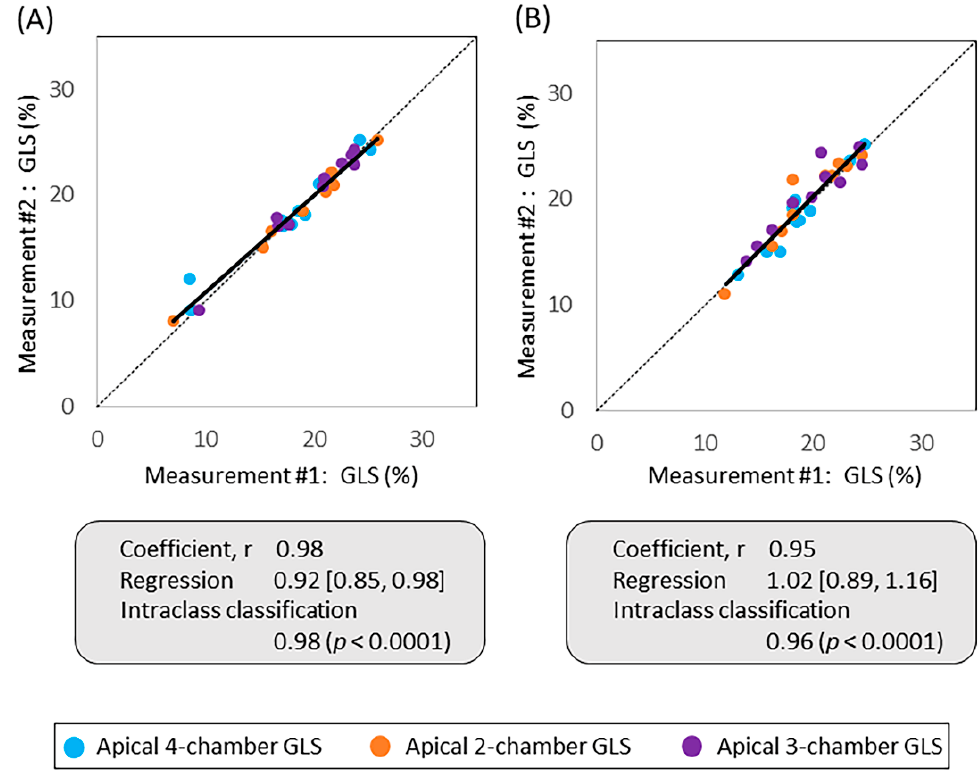
Figure 4. Intra-observer variability in apical 4-, 2-, and 3-chamber views. Linear regression comparing absolute GLS values Figure 4. Intra ‐ observer variability in apical 4 ‐ , 2 ‐ , and 3 ‐ chamber views. Linear regression compar ‐ ing absolute GLS values of 1st and 2nd measurement in ( A ) rHi ‐ FR and ( B ) Reg ‐ FR. GLS, global of 1st and 2nd measurement in ( A ) rHi-FR and ( B ) Reg-FR. GLS, global longitudinal strain; rHi-FR, relatively high frame longitudinal strain; rHi ‐ FR, relatively high frame rate; Reg ‐ FR, regular frame rate. rate; Reg-FR, regular frame